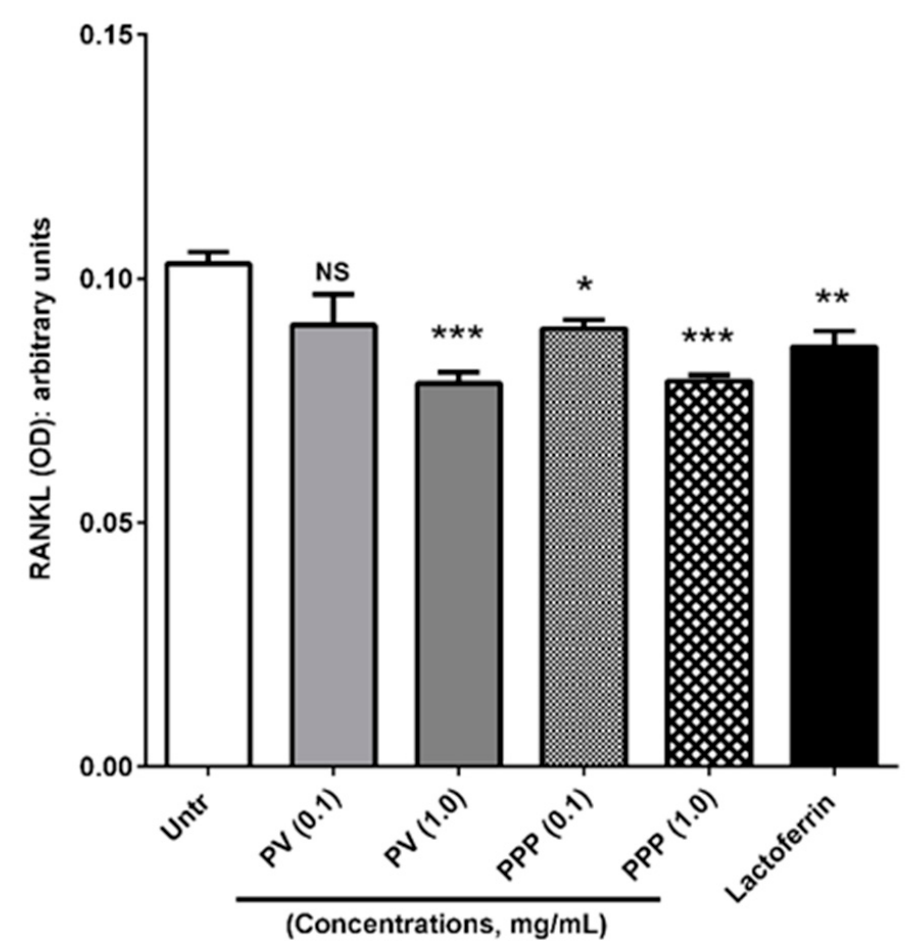
Figure 3. Both phosvitin and PPP reduce the levels of secreted RANKL from osteoblastic cells. Confluent monolayers of MC3T3-E1 cells were treated for 72 h with di ff erent concentrations (0.1 and 1.0 mg / mL) of phosvitin (PV) or PPP prior to collection of cell-free culture supernatants. These supernatants were analyzed for RANKL content by a commercially available ELISA kit. Lactoferrin (0.5 mg / mL) was used as a positive control. Data expressed as mean ± SEM of optical density (OD) values from 4